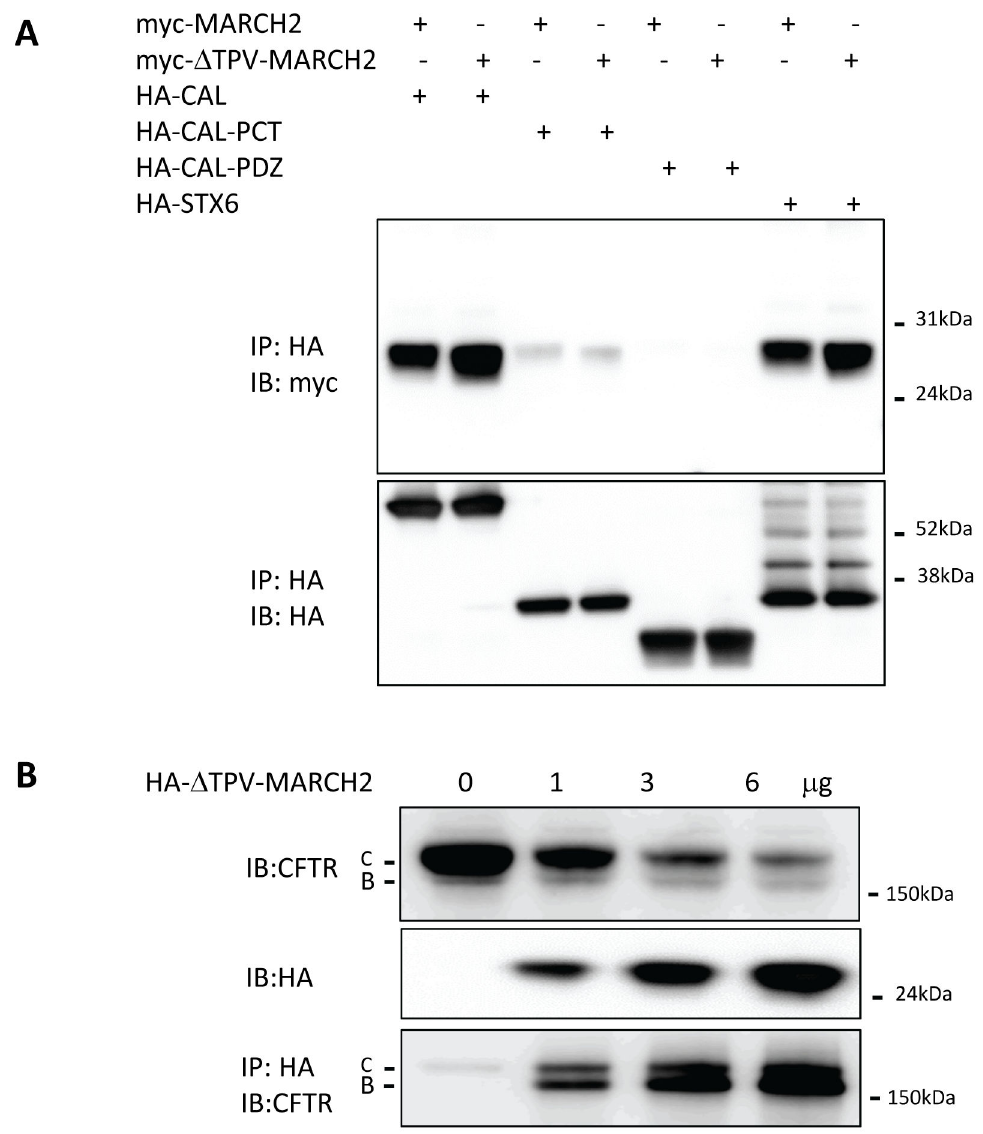
Figure 5. The PDZ binding motif of MARCH2 is not required for MARCH2 degradation of CFTR. ( A ) HEK293 cells were co- transfected with 3µg myc-MARCH2 or myc-ΔTPV-MARCH2 together with 3µg of HA-STX6 or several HA-CAL construct (see below), as indicated. After 48h, cell lysates were harvested and immunoprecipitated with an HA-affinity matrix. Cell lysates and immunoprecipitated materials were subjected to immunoblot analysis with the indicated antibodies. HA-CAL constructs used: HA- CAL (HA-tagged full length CAL), HA-CAL-PDZ (the HA-tagged PDZ domain of CAL) and HA-CAL-PCT (the HA-tagged PDZ and carboxyl domains of CAL) [18] ( B ) HEK293 cells were co-transfected with 3µg CFTR (pCMV-CFTR) and increasing amounts of HA- ΔTPV-MARCH2 as indicated. After 48 h, cell lysates were harvested and subjected to immunoblot analysis with the indicated antibodies. Data shown are representative of at least three independent experiments. doi: 10.1371/journal.pone.0068001.g005 bound. MARCH family proteins are the cellular homologs of the domain ubiquitin E3 ligases have two to four membrane- viral immune evasion proteins of the K3 family. When a panel spanning domains, consistent with their role in the of known substrates of viral K3 family proteins was tested, ubiquitination of the membrane protein CFTR. Interestingly, almost all MARCH members were found to degrade some cell- other E3 ligases that ubiquitinate CFTR (HRD1, RMA1, CHIP, surface glycoproteins. For instance, MARCH2 was found to and gp78), with the exception of CHIP, are also membrane- degrade TfR and B7.2, but not MHC I [30]. Whether they